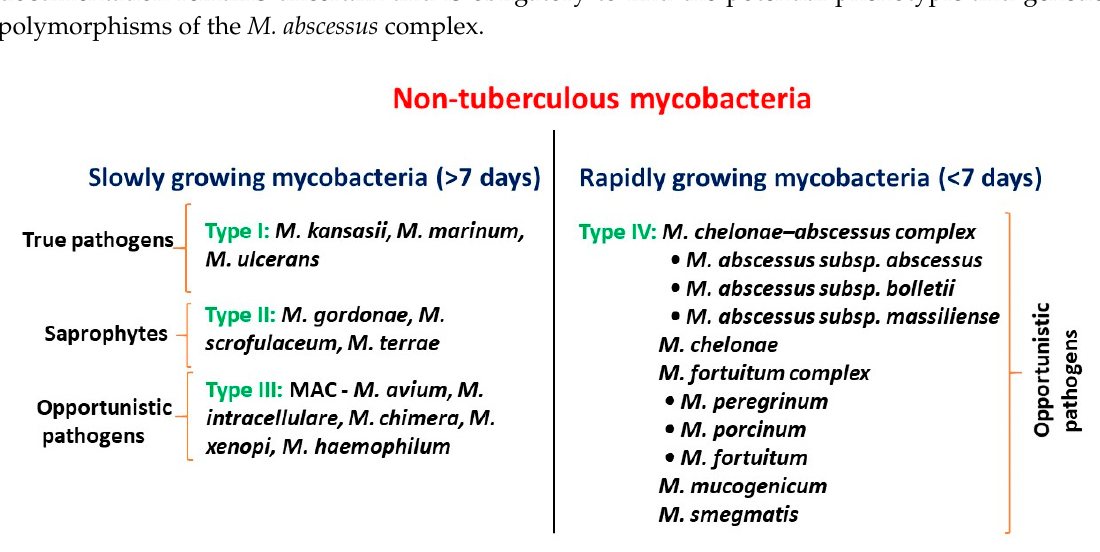
Figure 1. Classification of nontuberculous mycobacteria.